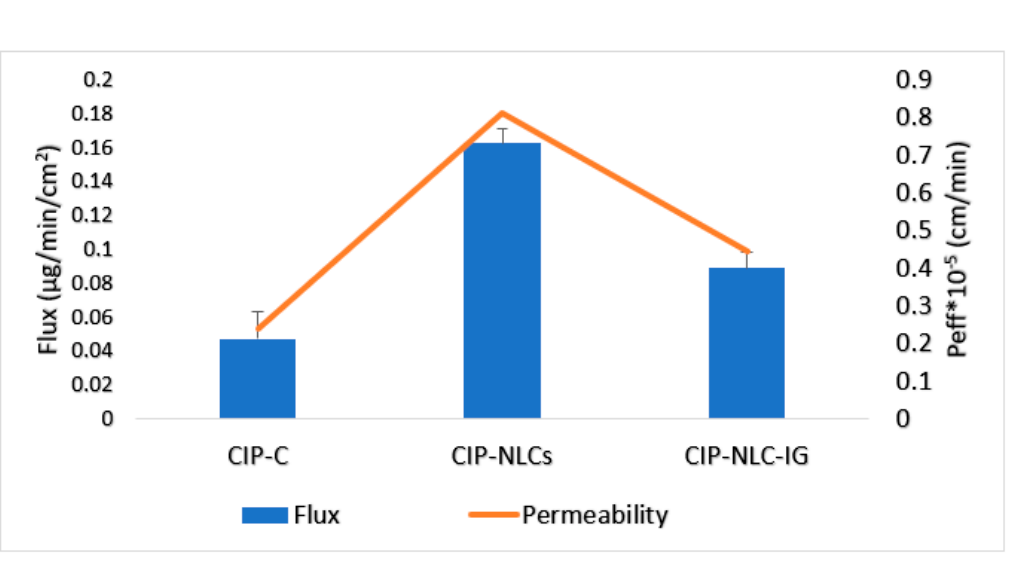
Figure 5. Transcorneal flux and permeability of CIP from optimized CIP-NLC, CIP-NLC-IG2, and CIP-C through the isolated rabbit cornea (mean ± SD, n = 3).